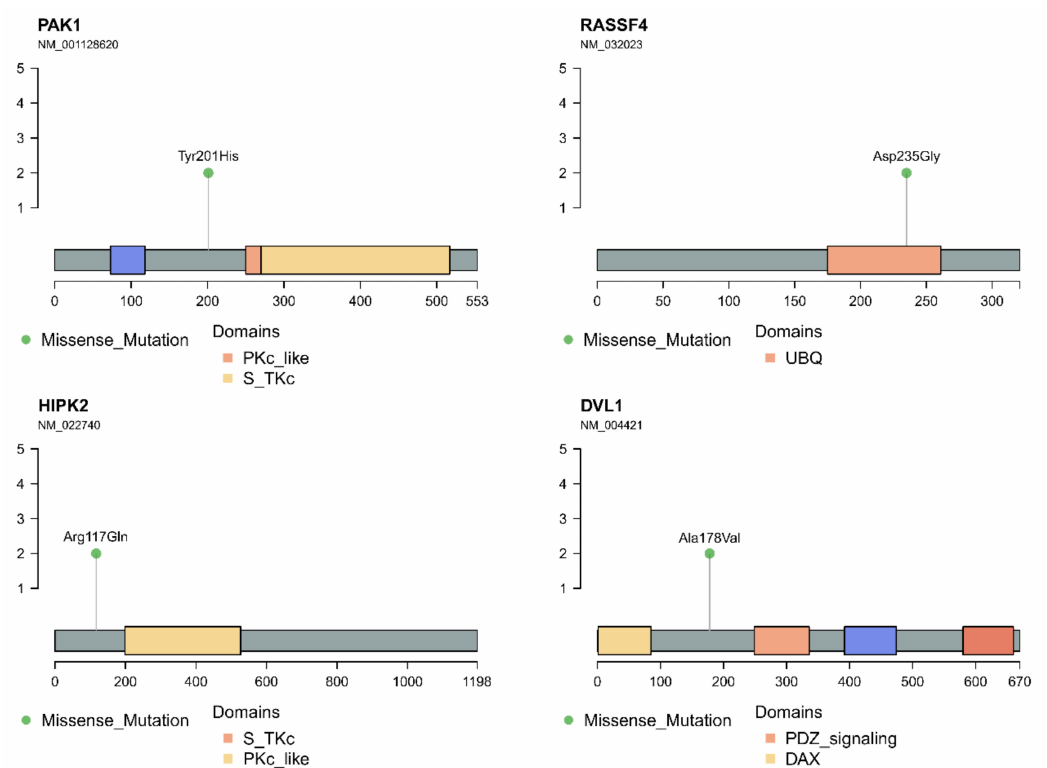
Figure 3. Amino acid change and localization relative to the respective protein domains in the four proteins (PAK1, RASSF4, HIPK2 and DVL1) whose corresponding genes belong to the Hippo pathway and are mutated in a RAS -positive cohort. Brackets from 1 to 5 indicate the number of samples positive for each mutation. In our RAS -positive samples, the alteration of each gene was present in two